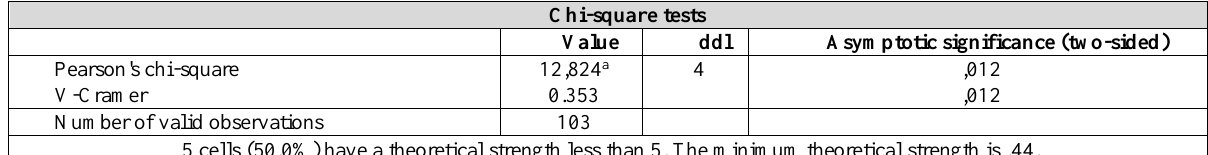
Table 4. Chi-square and V-Cramer Test Between Expenses and the Relationship Within the Couple Chi-square